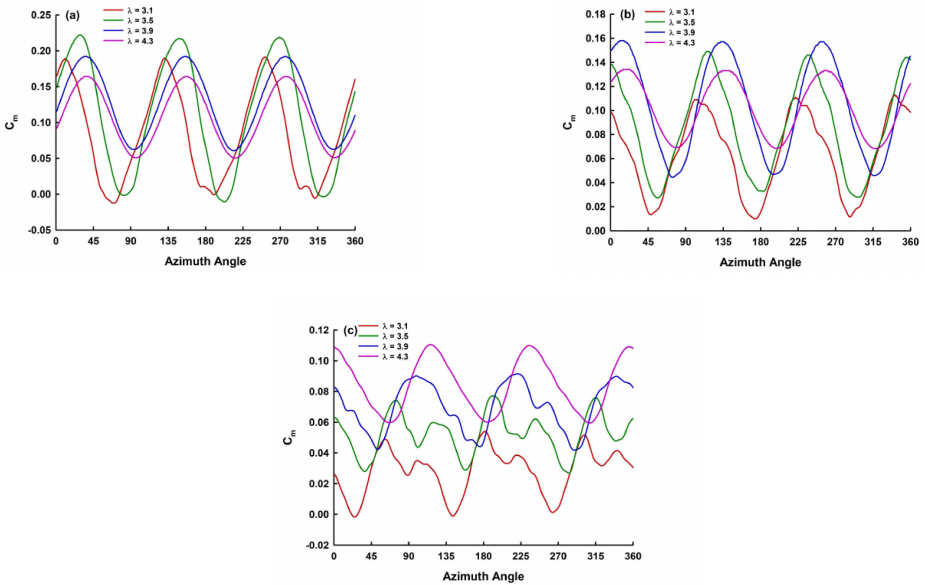
Figure 11. Cumulative C m plot for helical turbine having ( a ) ψ = 60 ◦ , ( b ) ψ = 90 ◦ , and ( c ) ψ = 120 ◦